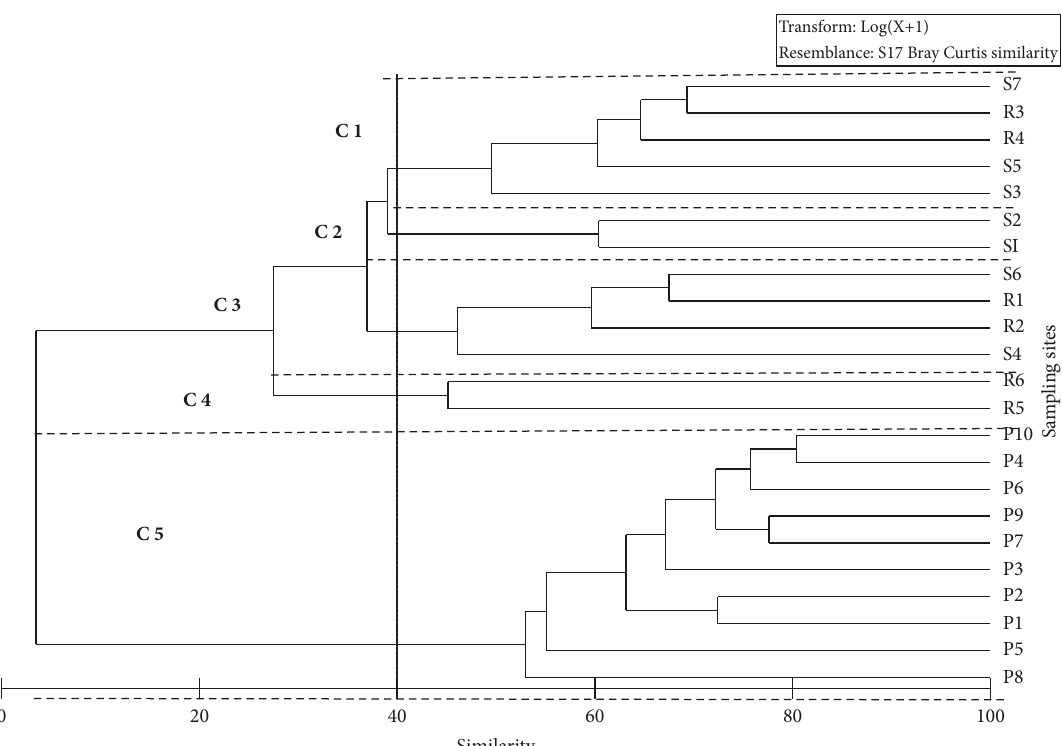
Figure 9: Group average dendrogram of similarity of species composition for Odonata among the water types in the Ankasa conservation